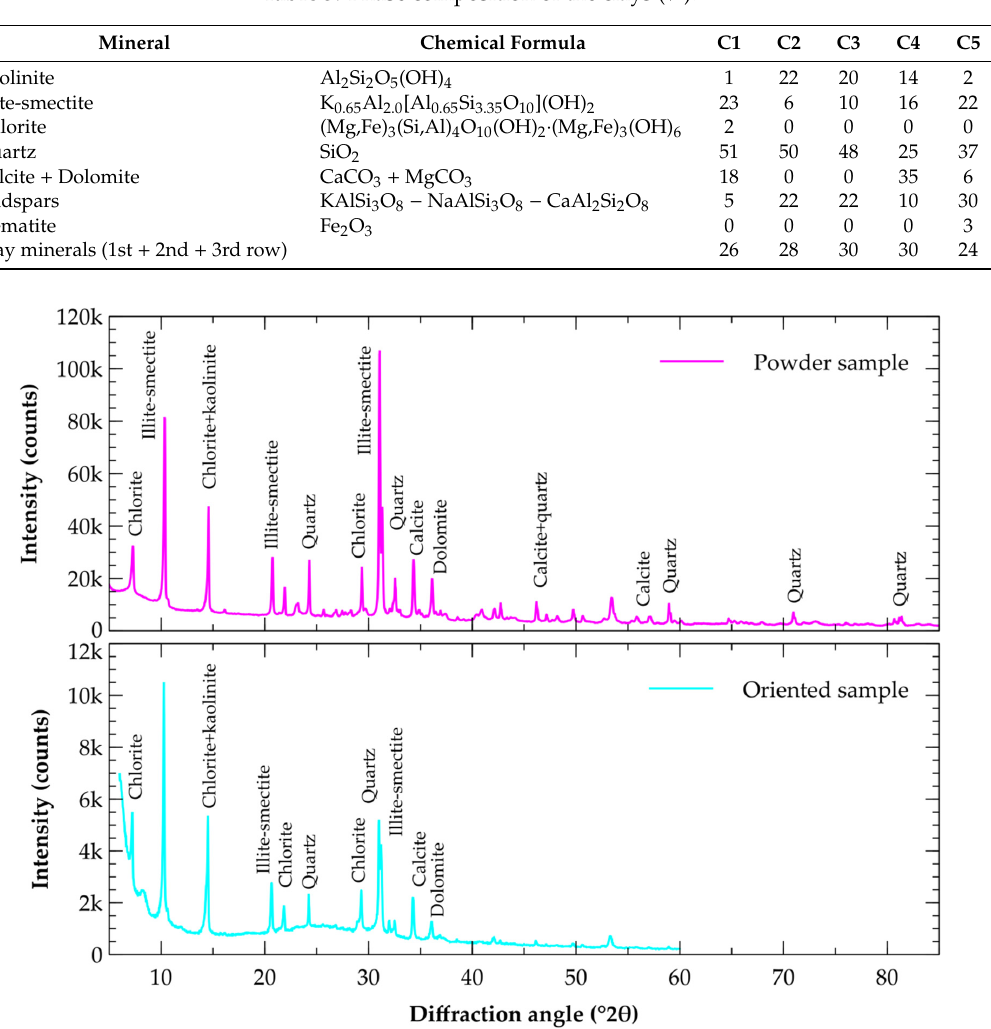
Figure 2. XRD di ff ractogram of the C1 Figure 2. XRD diffractogram of the C1 sample.